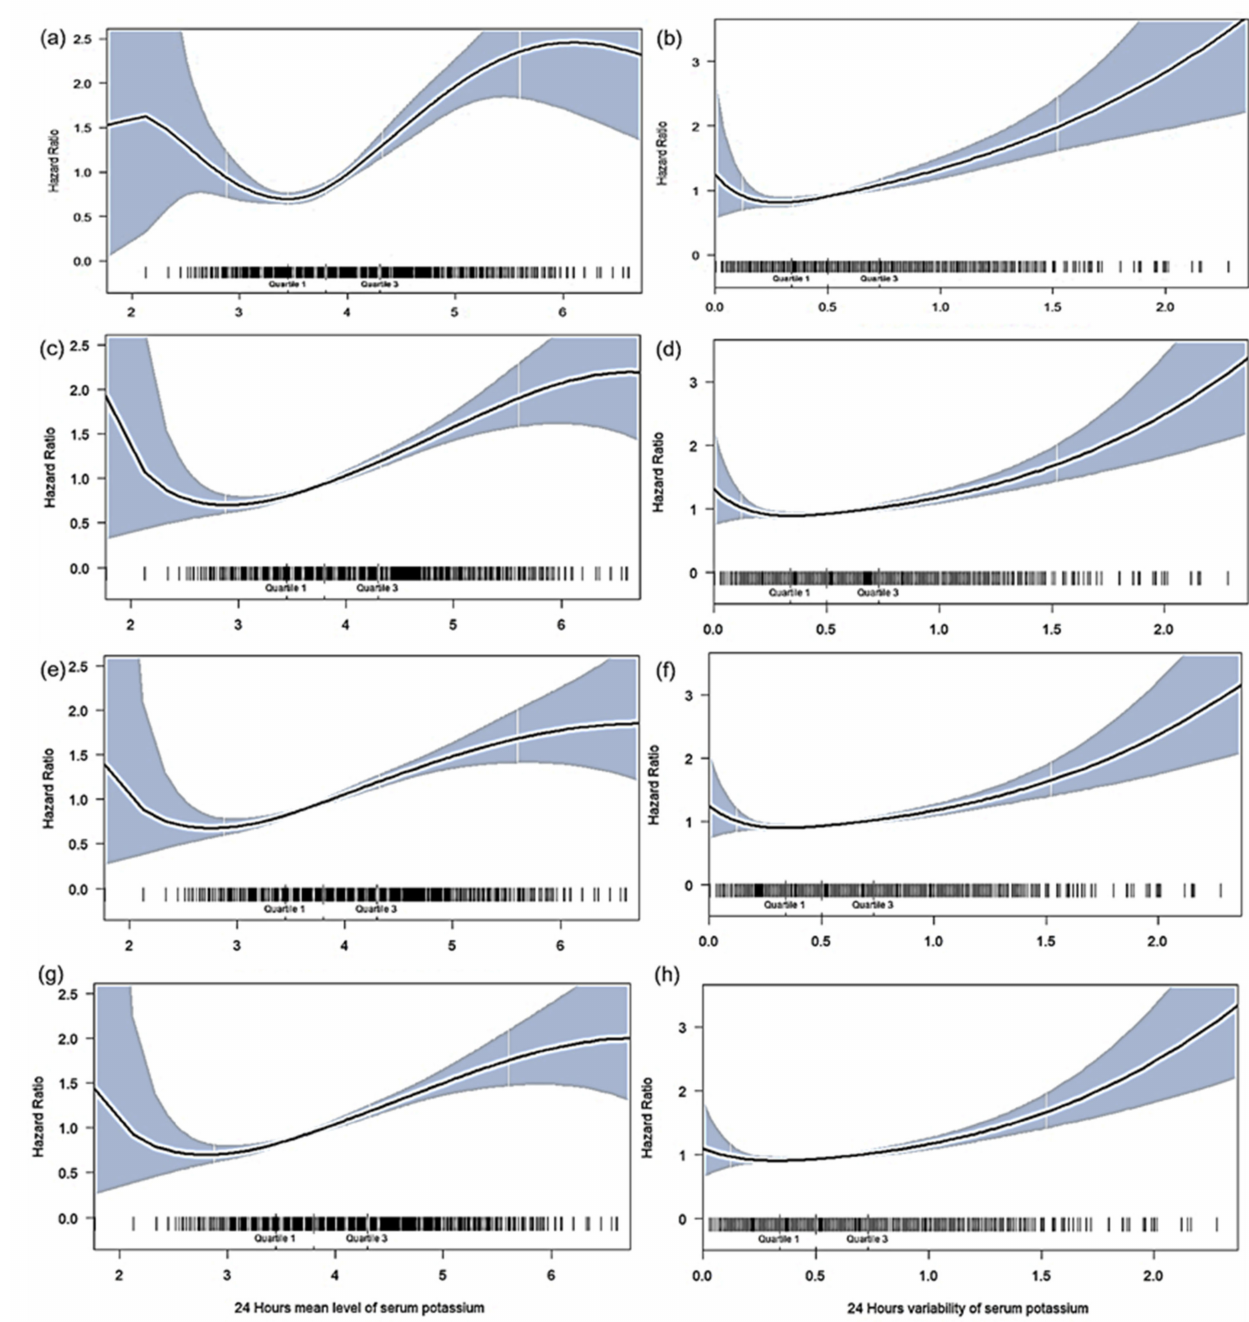
Figure 3. The restricted cubic spline plots depicting the association between serum (K+) level, variability and mortality risk. ( a ) 72-h mortality on serum (K+) level; ( b ) 72-h mortality on serum (K+) variability; ( c ) 28-day mortality on serum (K+) level; ( d ) 28-day mortality on serum (K+) variability; ( e ) 90-day mortality on serum (K+) level; ( f ) 90-day mortality on serum (K+) variability; ( g ) In-hospital mortality on serum (K+) level; ( h ) In-hospital mortality on serum (K+)